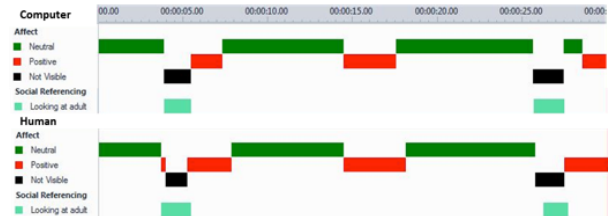
Figure 2: Time-based coding by automated computer (top) and human (bottom) methods demonstrating high agree- ment (subject 9; stimulus 1) with 27 out of 30 seconds agree- ment. Green is neutral expression, red is positive expres- sion, black is not visible, and light green is social referencing (looking at adult).